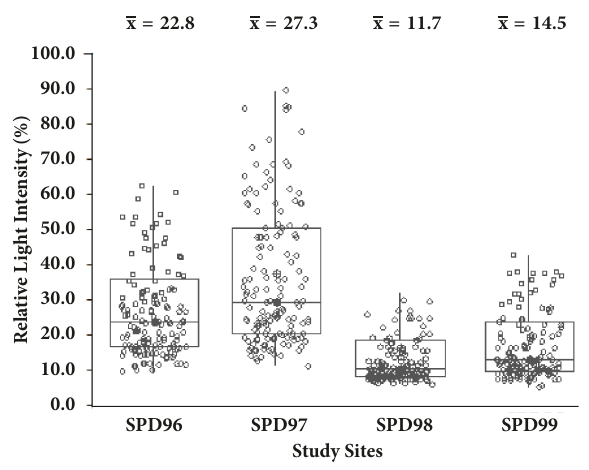
Figure 5: Boxplots: average relative light intensity of planted S. macrophylla in SPD96, SPD97, SPD98, and SPD99. The boxplots (box and whisker illustrations) display data on values of minimum, maximum, first quartile, third quartile, interquartile range, and median as shown in the figure above. x: mean value; n: number of RLI